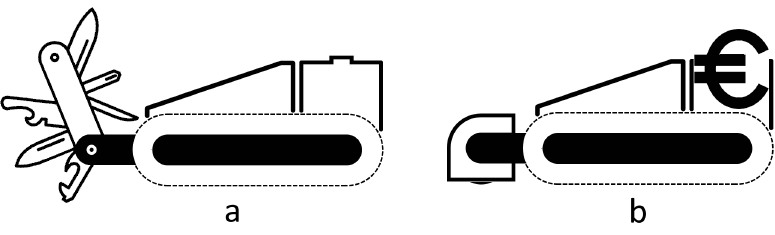
Figure 8. Key metrics: ( a ) tools or attachments; ( b ) availability and price.